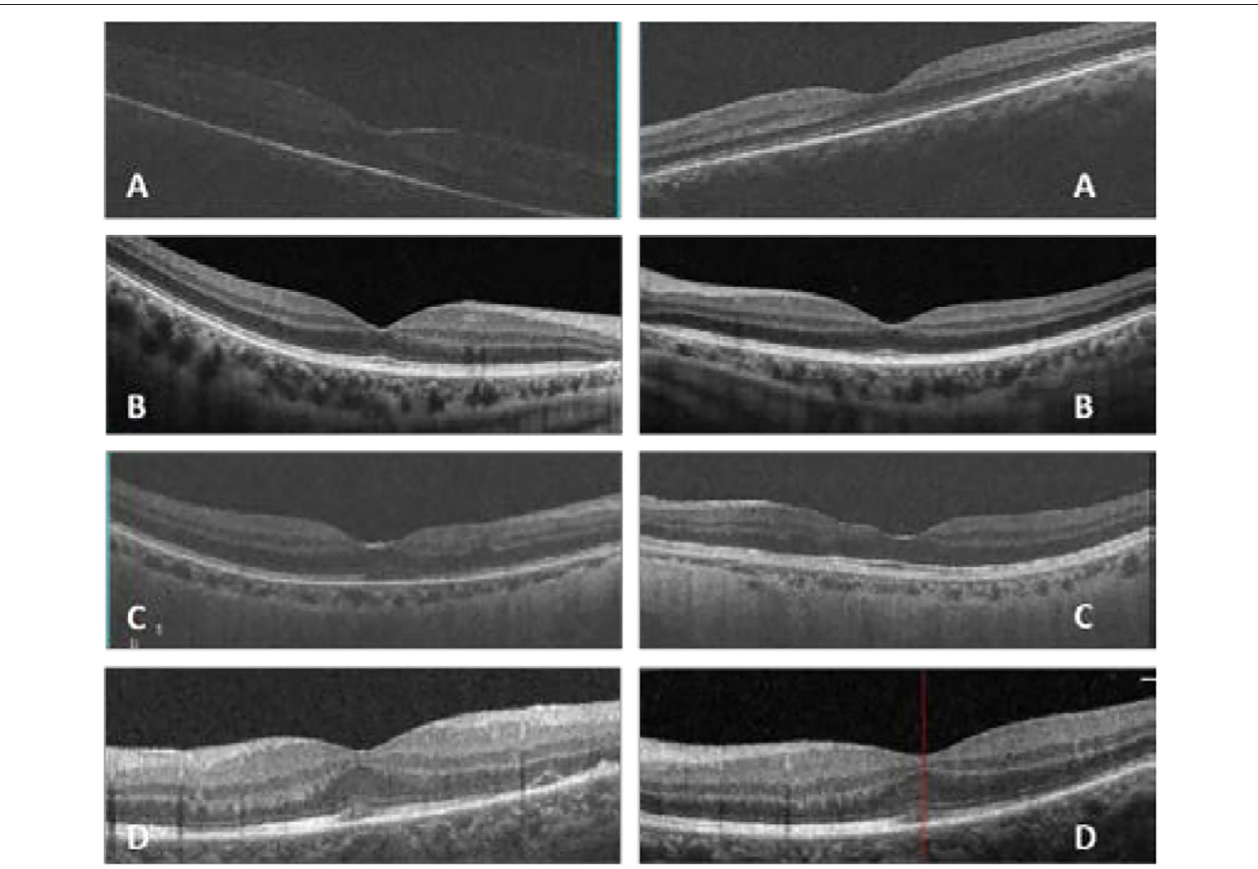
FIGURE 2 | In patient one (A) , optic coherent tomography (OCT) showed an epiretinal membrane in macular in the right eye; in patient two (B) , OCT was normal in macular in both eyes; in patient three (C) , OCT showed a slight epiretinal membrane and inner retina disorder in macular in both eyes; in patient four (D) , OCT showed a slight epiretinal membrane and a minor retinal neurosensory layer detachment in the left eye (Left: the right eye, right: the left eye, (D) shows only the left eye for the atrophy of the right